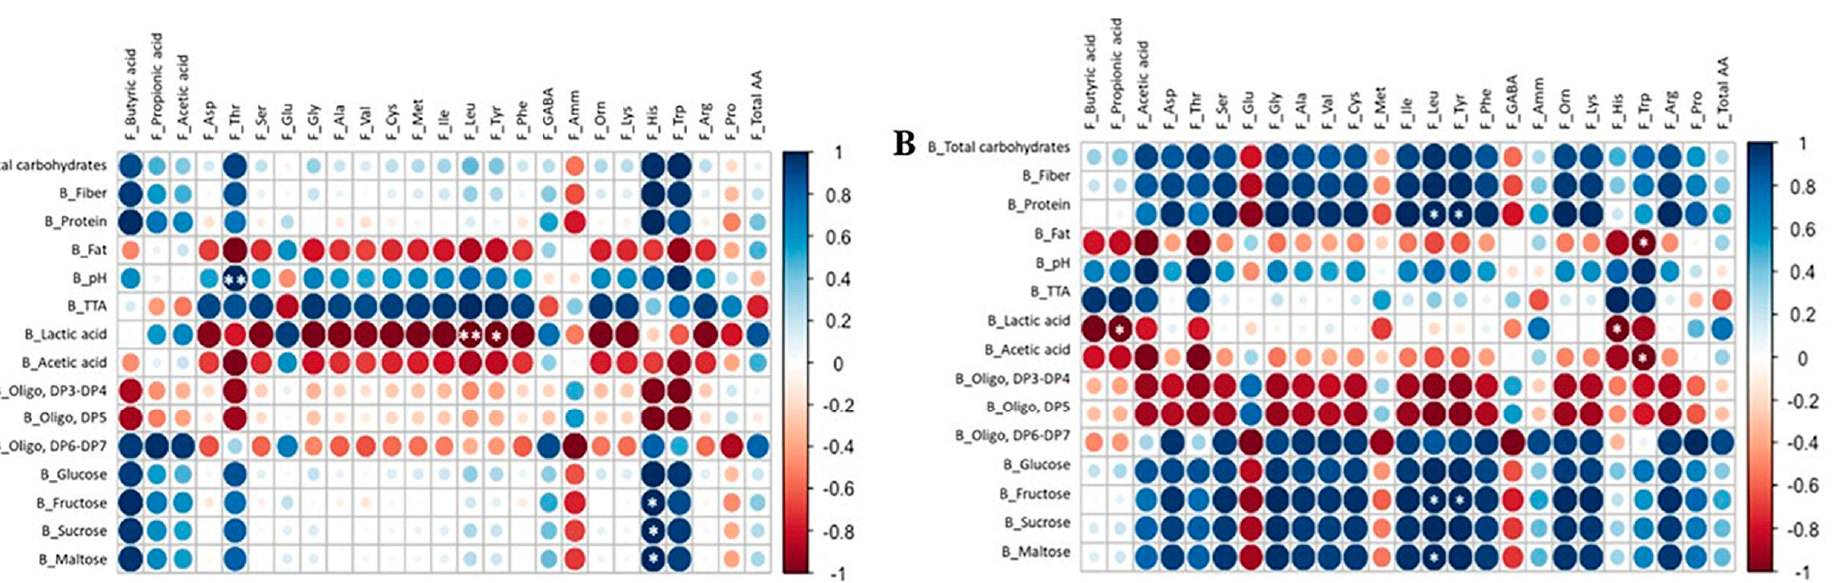
Figure 4. Pearson correlation among EPS-BB content of total carbohydrate, dietary fiber, protein, fat, lactic and acetic acids, dextran, malto-oligosaccharides (DP3–DP7), glucose, fructose, sucrose, maltose, pH, total titratable acidity (TTA) and microbial metabolites (short chain fatty acids and free amino acids) in proximal ( A ) and distal ( B ) colon after one week of treatment period. ( B ) indicates bread variables. F indicates fecal sample variables. The color scale bar indicates a positive (blue) or negative (red) correlation (* p < 0.05, ** p < 0.01).